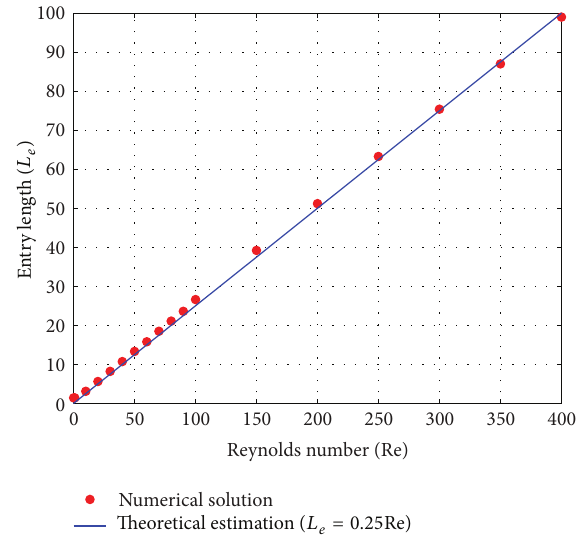
Figure 4: Steady entrance length 𝐿 𝑒 versus Reynolds number Re without applying magnetic field ( Ha = 0) .